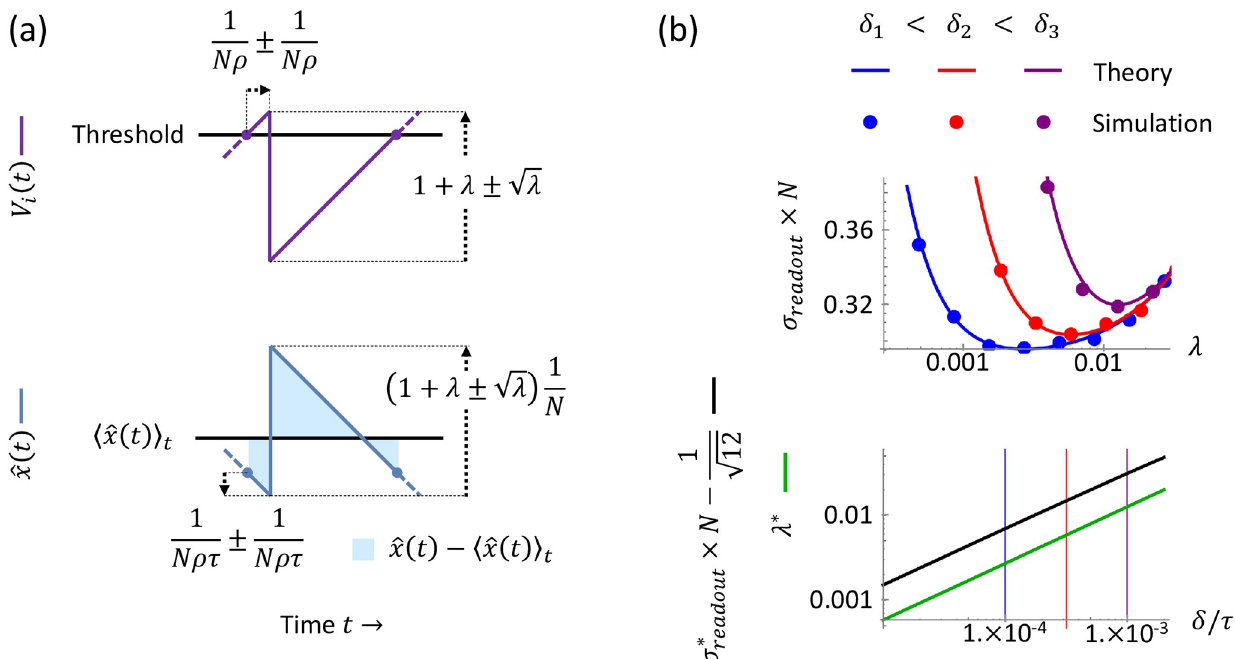
Fig 2. Soft-threshold readout error. (a) The soft-threshold and the delay create variations in the membrane potential dynamics V ( t ), which in turn create i variations in the readout ^ x ð t Þ . When the membrane potentials (top, purple) surpass threshold, the neurons spike probabilistically, and the first-spike time is an exponential random variable with standard deviation 1 . After a first spike, the number of spurious spikes that occur during the delay is a Poisson N r ffiffiffi p random variable, with standard deviation l , and each spike inhibits the membrane potentials V i ( t ) by 1 through recurrent connectivity (see the first paragraph of Results for recurrent connectivity). These variations in spike-timing and spurious spikes carry through to the readout ^ x ð t Þ (bottom, blue). Note that since the network input is constant, the readout encoding this input should produce a constant output as closely as possible; however, these (black horizontal line). (b) Readout error as a function of the variations instead increase the deviation (light blue shaded) from the mean readout h ^ x ð t Þi t mean number of spurious spikes λ and the delay δ . Top: for three different values of delay (blue, red, purple), λ is varied in computer simulations (N = 32, dots) and Eq 10 (solid curves), revealing both the U-shaped dependence of the readout error σ and an excellent match between theory and readout experiment. Bottom: the optimal readout error s � (black) and the associated optimal λ � increase as a function of delay δ according to Eqs 12 and 11. readout